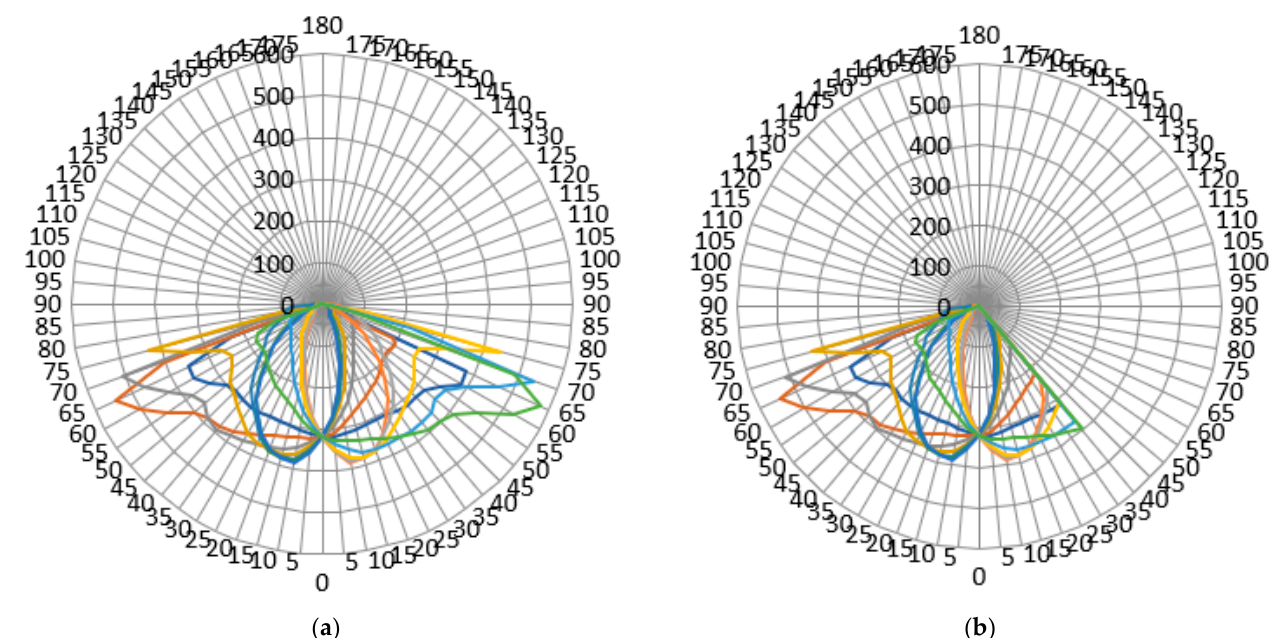
Figure 1. Asymmetrical light density distribution of a typical road luminaire ( a ). Non-symmetrical light density distribution of a road luminaire meeting the required luminance distributions from the observation point of one of two typical computational observers ( b ).